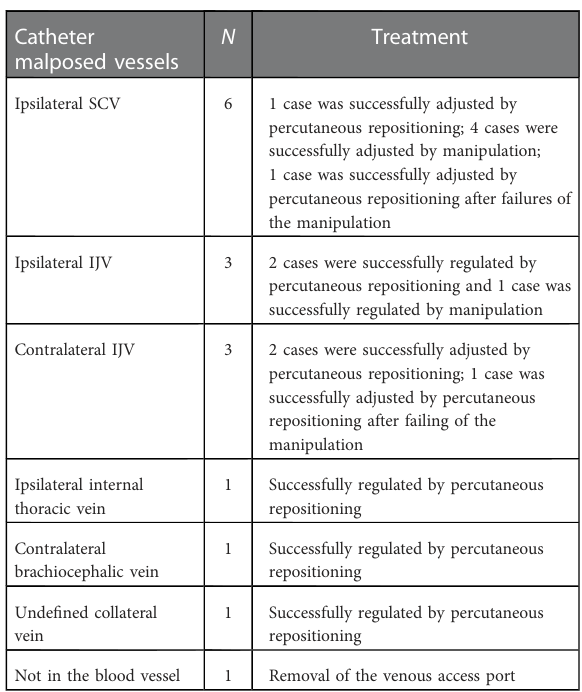
TABLE 4 Details of catheter malposition and